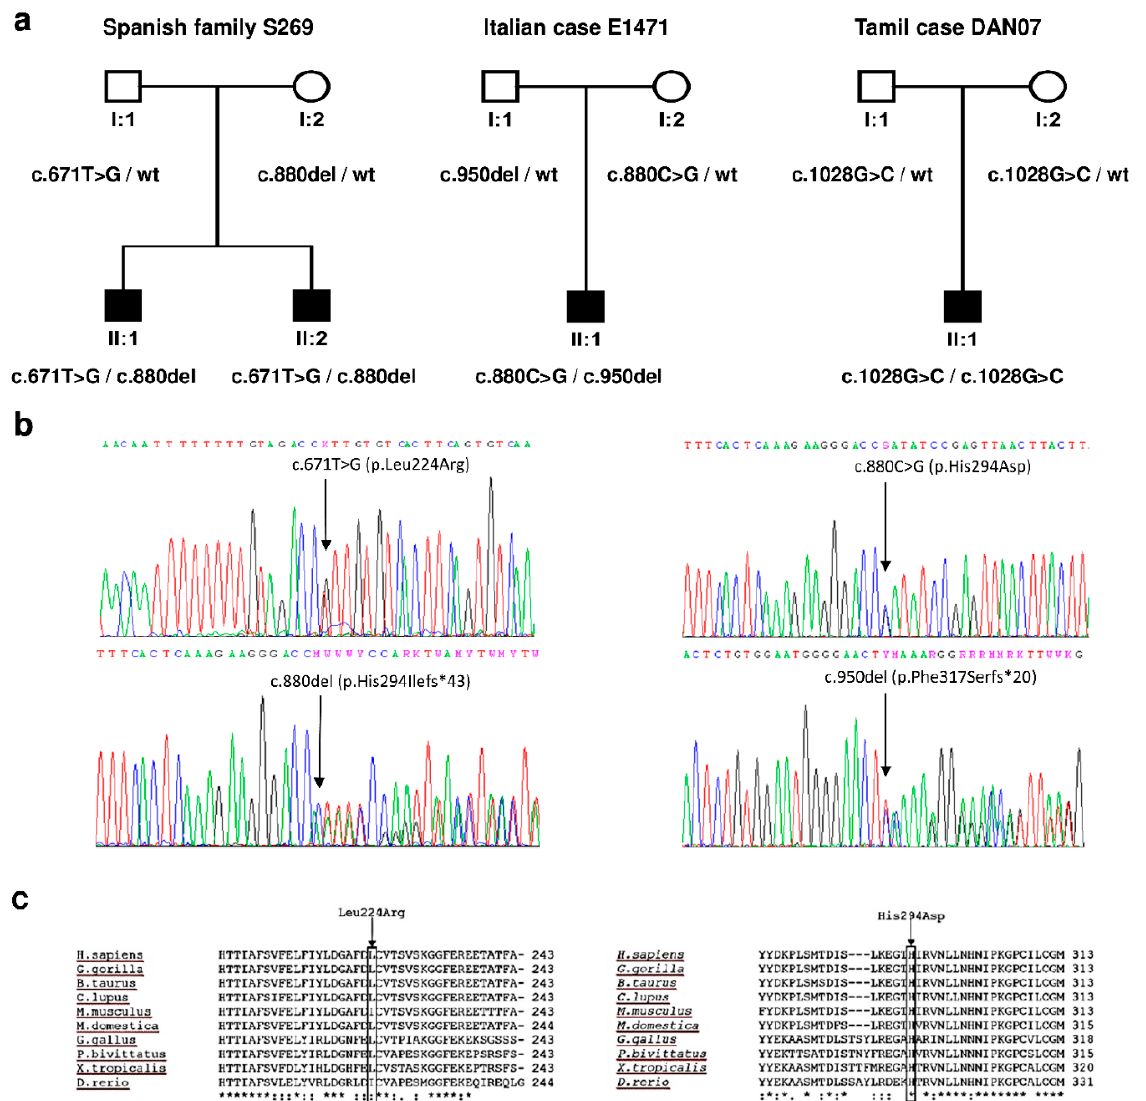
Figure 1. Novel pathogenic variants that were found in this study. ( a ) Pedigrees showing the segregation of variants. ( b ) Electropherograms from subject S269 II:1 (left panel) and from subject E1471 II:1 (right panel). ( c ) Alignment of pejvakin orthologous sequences from human and nine other vertebrates. Asterisks indicate identical residues across all sequences; colons, conserved positions (residues of strongly similar properties); periods, semi-conserved positions (residues of weakly similar properties). Sequence accesion numbers: Homo sapiens (NP_001036167.1); Gorilla gorilla (XP_004032916.1); Bos taurus (NP_001180112.1); Canis lupus (XP_535979.2); Mus musculus (NP_001074180.1); Monodelphis domestica (XP_001368857.1); Gallus gallus (XP_426573.2); Python bivittatus (XP_007433246.1); Xenopus tropicalis (XP_012826511.1); Danio rerio (XP_009300492.1).